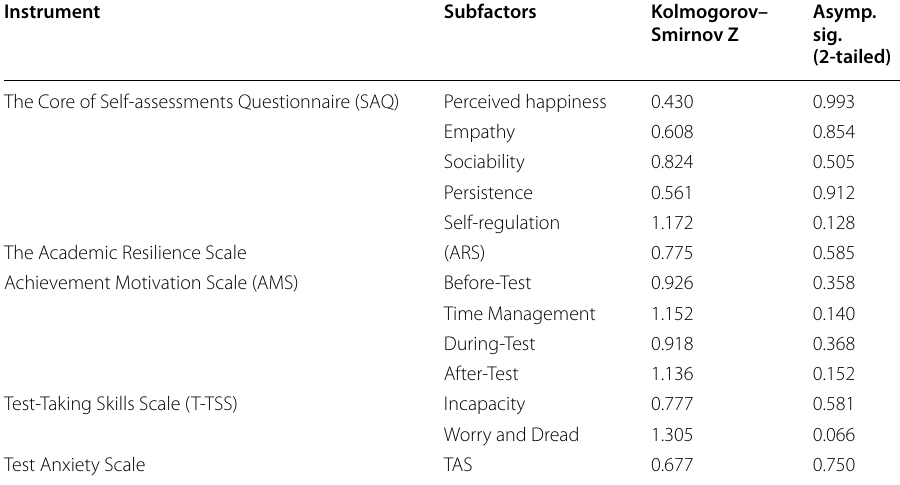
Table 2 The results of Kolmogorov–Smirnov